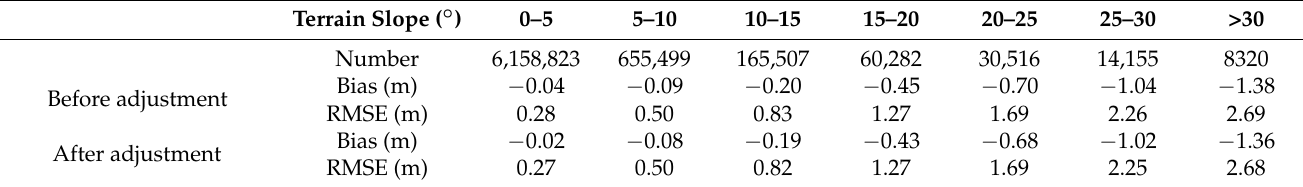
Table 7. Accuracy of the ICESat-2 data before and after adjustment in different terrain slopes.